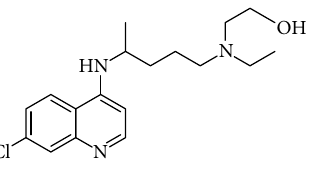
Figure 7: Molecular graph of Hydroxychloroquine. Table 3: Edge partitioning based on degree of Hydroxychloroquine.